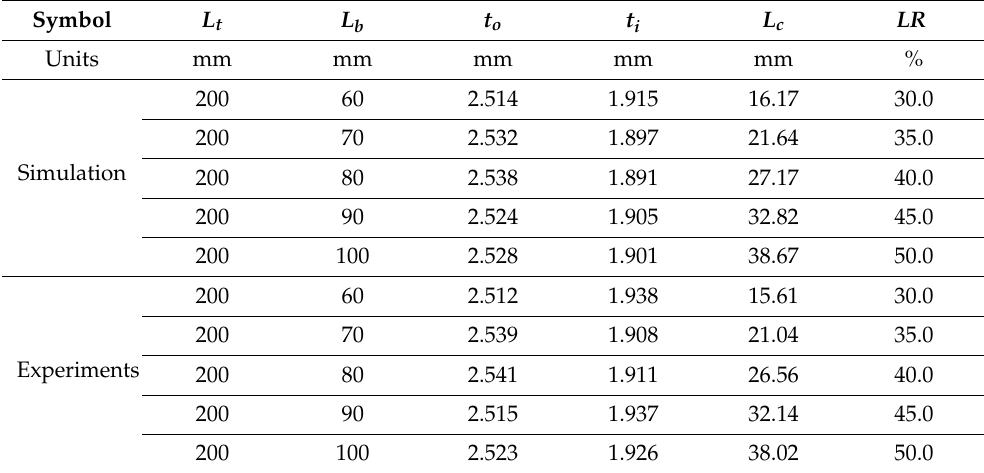
Table 4. Dimensional measured values of forged bi-metal